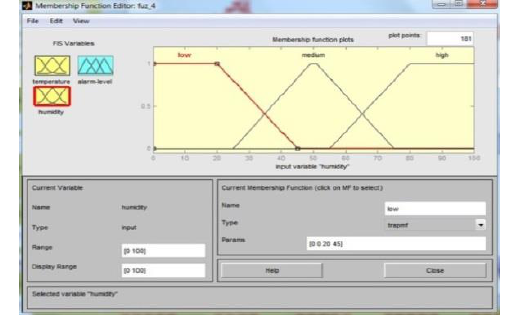
Figure 24. Membership functions for humidity (input) and its range.